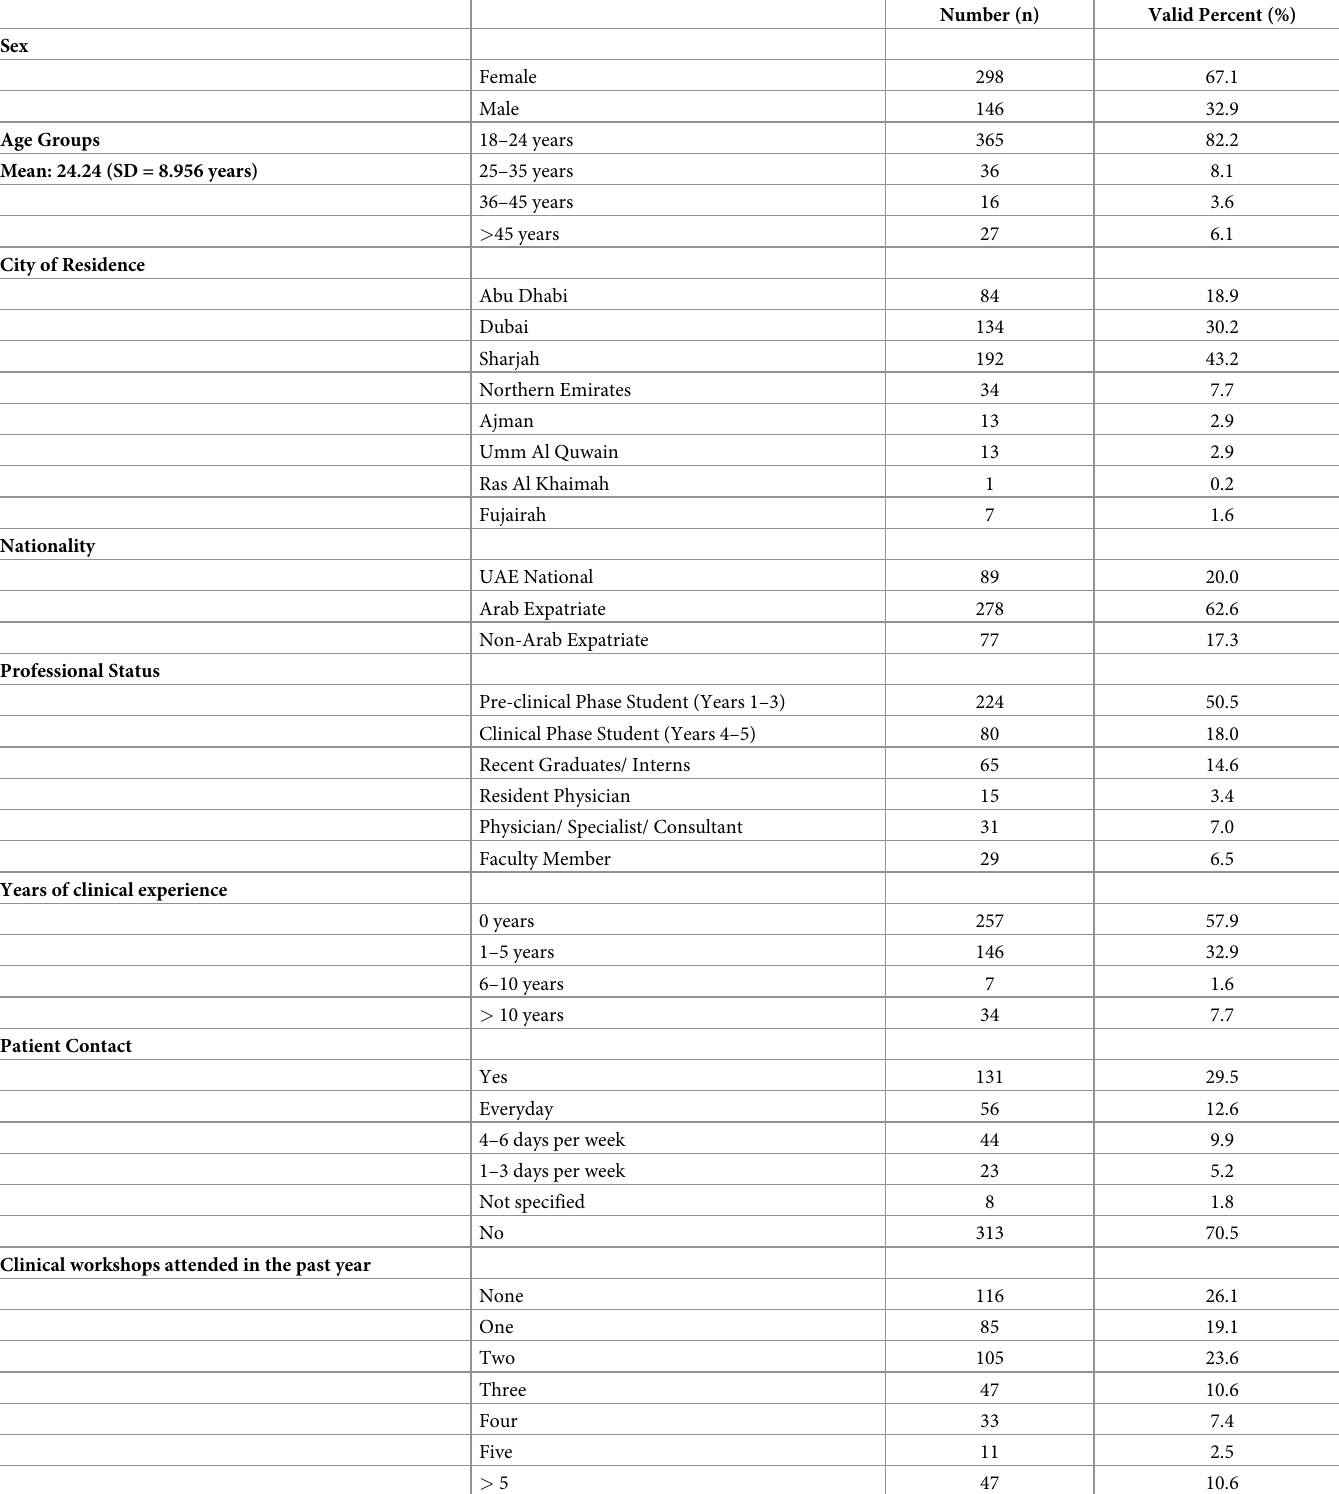
Table 1. Demographic data of study